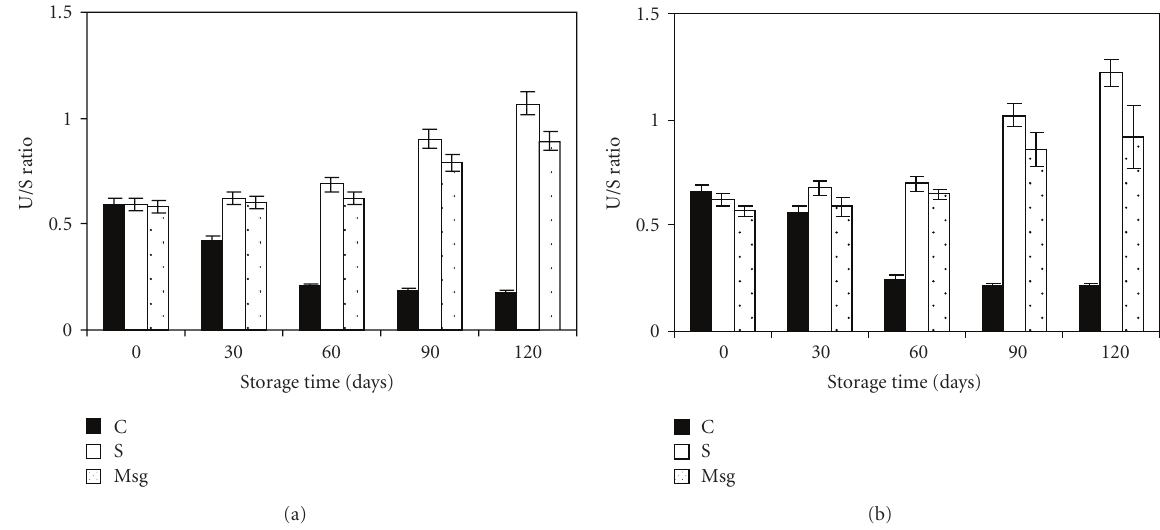
Figure 1: Impact of storage time upon U/S ratio of freeze-dried lactobacilli during 120 days at room temperature in vacuum-sealed aluminium foil. Values are presented as means ± standard deviation (SD, n = 4). (a) L. paracasei ssp . paracasei LMG 9192 T , (b) L. plantarum CWBI-B1419 T and (c) control ( (cid:2) ), sorbitol ( (cid:3) ) and monosodium glutamate ( (cid:2) ). Table 2: Moisture content and survival of two strains of lactobacilli after freeze-drying with 12 g/L monosodium glutamate and 12 g/L sorbitol. Each value represents the mean of replicates from 2 freeze-drying experiments. Vacuum-sealed aluminium